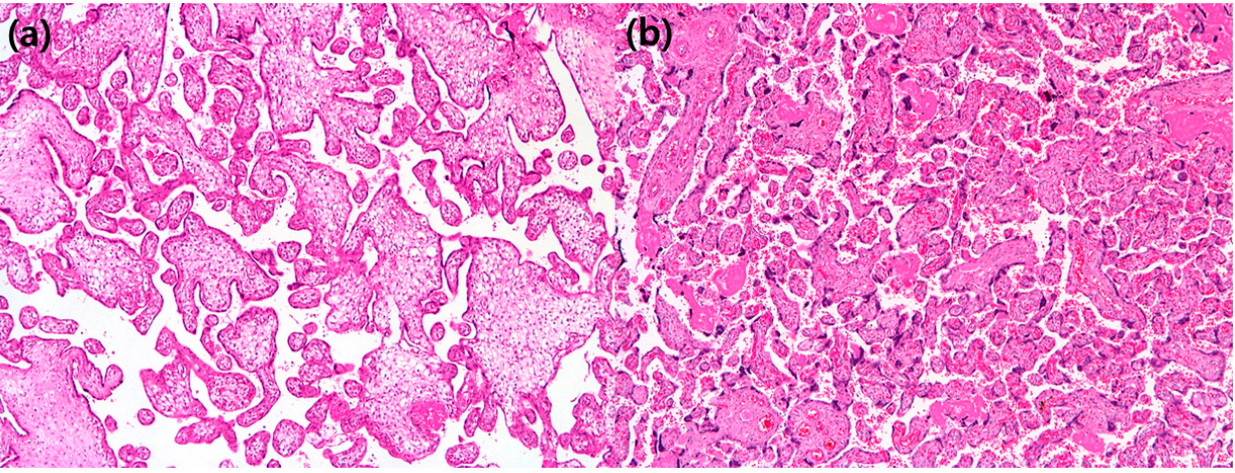
Figure 2. ( a ) In this patient with a preterm placenta, syncytial knots are barely seen (×40 hematoxylin and eosin); ( b ) in this patient with a preterm placenta, syncytial knots are rated as 90%, suggestive of “increased syncytial knots” (×40 hematoxylin and eosin).